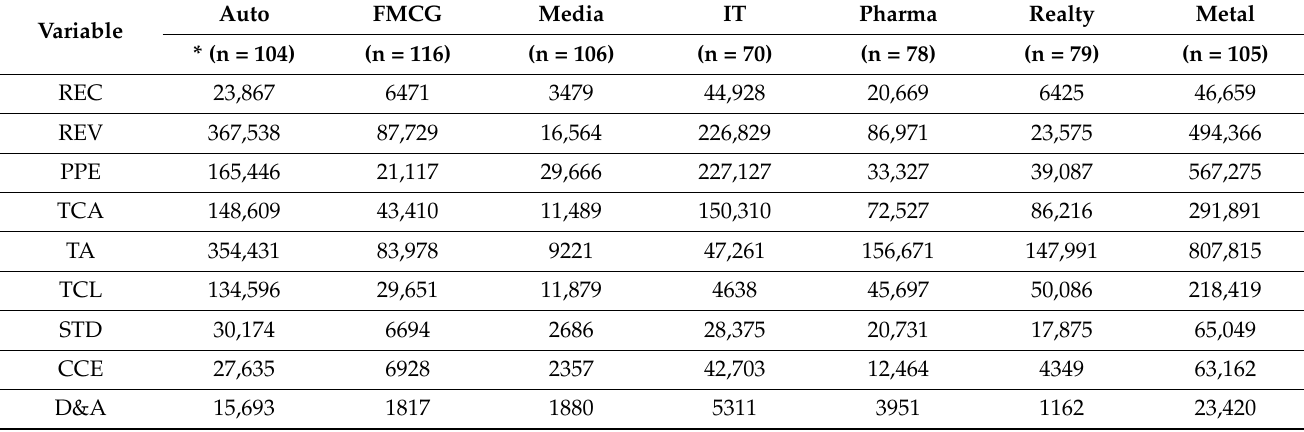
Table 2. Industry wise mean values of the variables (in million rupees).